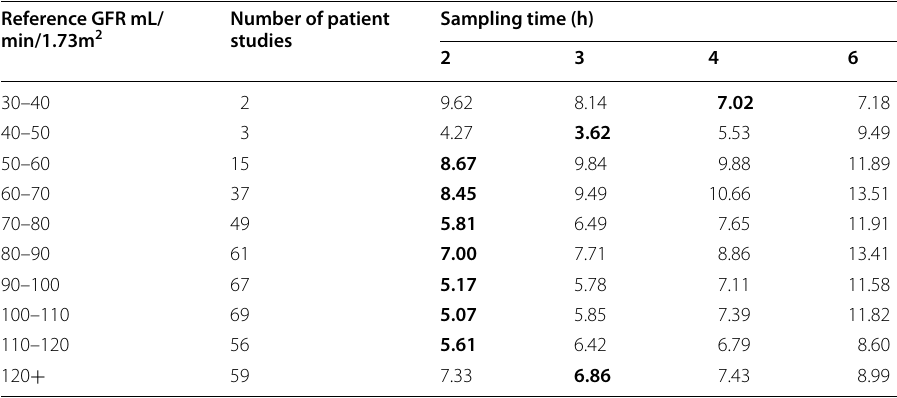
Lowest values are highlighted in bold text